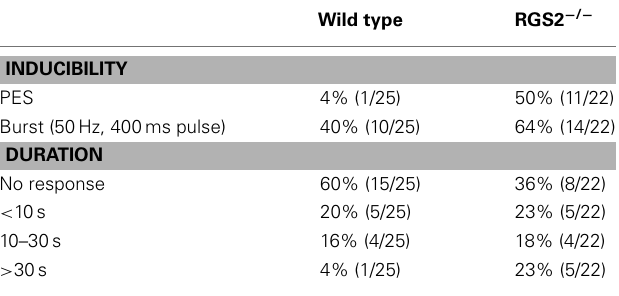
Table 1 | Incidence ofAT/F induced by PES or burst pacing and maximum duration of inducedAT/F with either PES or burst pacing